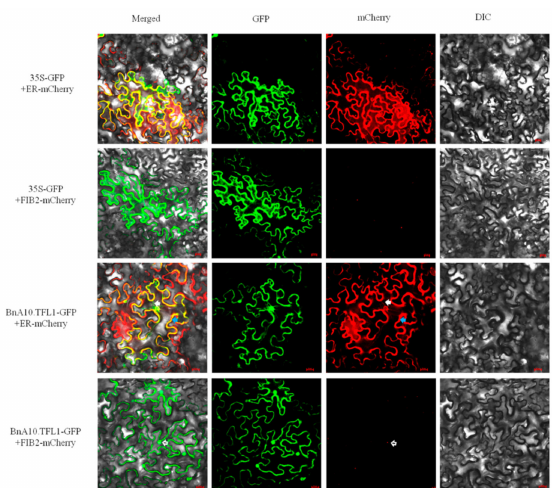
Figure 6. The subcellular location of the BnA10.TFL1 protein in Nicotiana benthamiana epidermal cells. The ER-mCherry was used as a marker for ER-rb CD-960, FIB2-mCherry was used as a nuclear marker, 35S-GFP + ER-mCherry and 35S-GFP + FIB2-mCherry were used as control; the hollow white arrow refers to the nuclear, the solid white arrow refers to the filamentous substance in the cytoplasm, the solid blue arrow refers to plasma membrane; scale bar = 20 µ